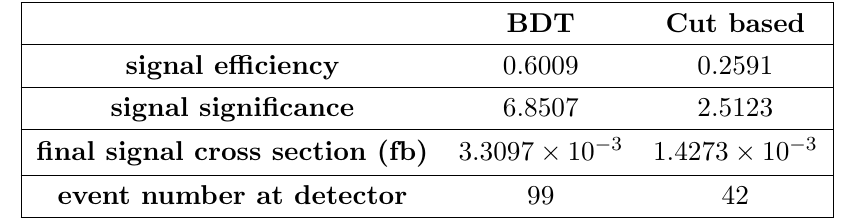
Table 9 . Cut (cid:13)ow table for H (cid:7) H (cid:6)(cid:6) ! hW (cid:7) W (cid:6) W (cid:6) under basic cuts (bc) and hard cuts (hc) with integrated luminosity of 30 ab (cid:0) 1 . Here we use the same abbreviations as in table 5.